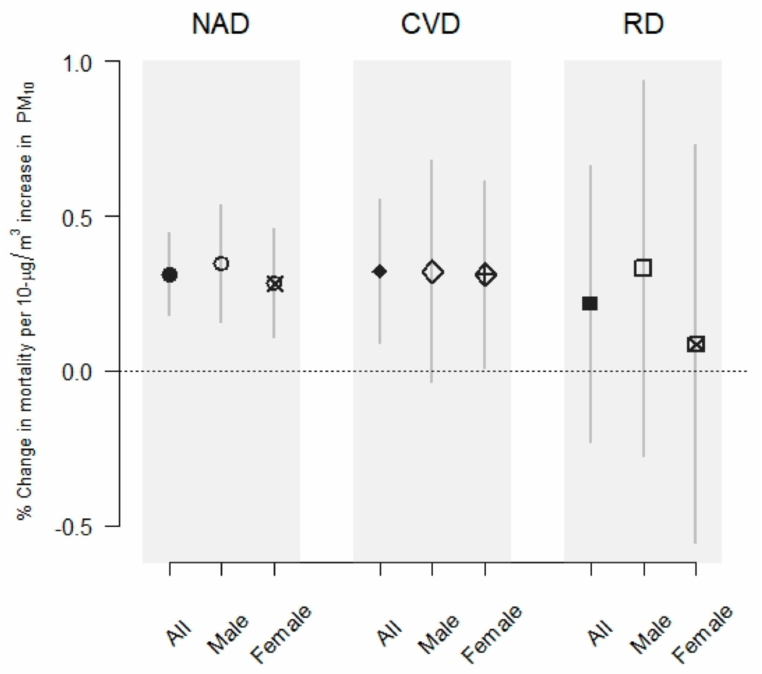
Figure 3. Percent changes in non-accidental death (NAD), cardiovascular disease (CVD), and respiratory disease (RD) mortalities in elderly Seoul residents, with a 95% confidence interval, for a 10 µ g / m 3 increment in PM 10 at MA03 (the moving average for the current day and the previous 3 days). We plotted the risks associated with a 10 µ g / m 3 increment in PM 10 in terms of non-accidental death and mortalities from cardiovascular and respiratory disease, stratified by temperature ( < 1st, 1st to < 5th, 5th to < 25th, 25th to < 75th, 75th to < 95th, 95th to < 99th, and ≥ 99th percentiles) (Figure 4). Associated with this PM 10 increment was an increasing trend in the risk of non-accidental death and cardiovascular disease mortality as the temperature increased. In these stratification models, an increase of 10 µ g / m 3 death and a 3.05% (95% CI: 1.76% to 4.36%) increase in cardiovascular mortality on very hot